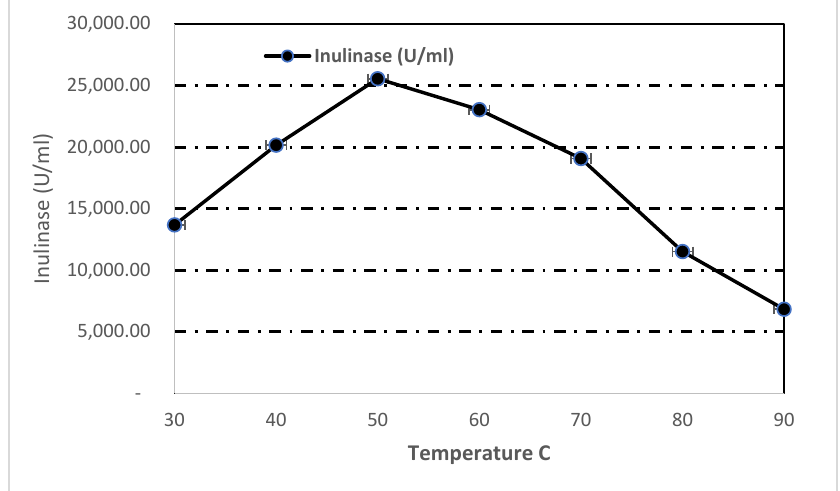
Figure 3. Temperature optima of the purified inulinase from Rhizopus oryzae NRRL 3563.